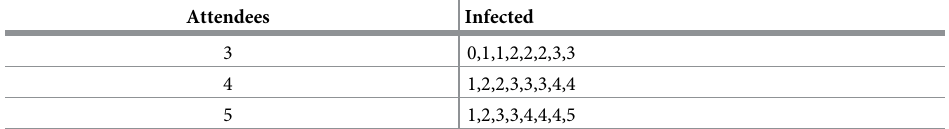
Table 1. Number of attendees and persons infected at each of the 8 samples per